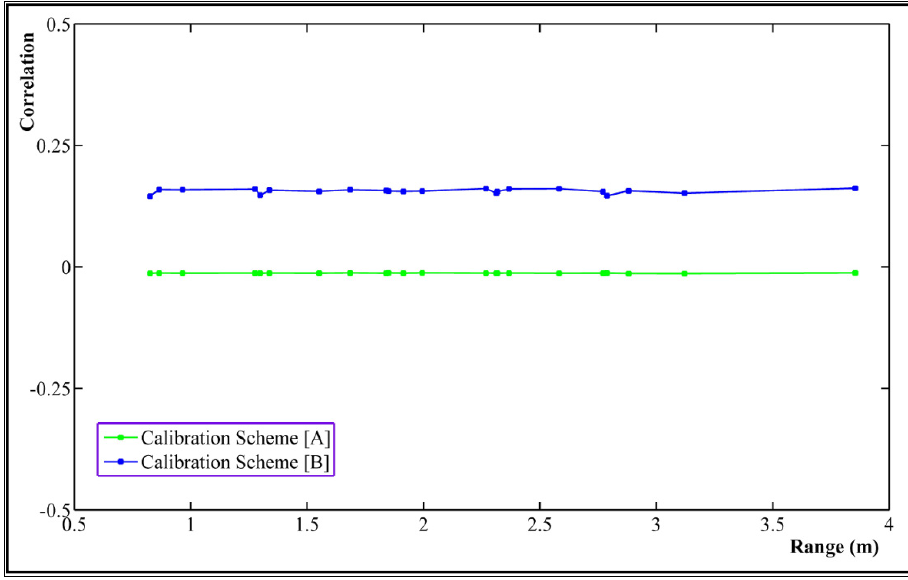
Figure 9. Correlations between rangefinder offset and perspective centre of PMD camera vs.